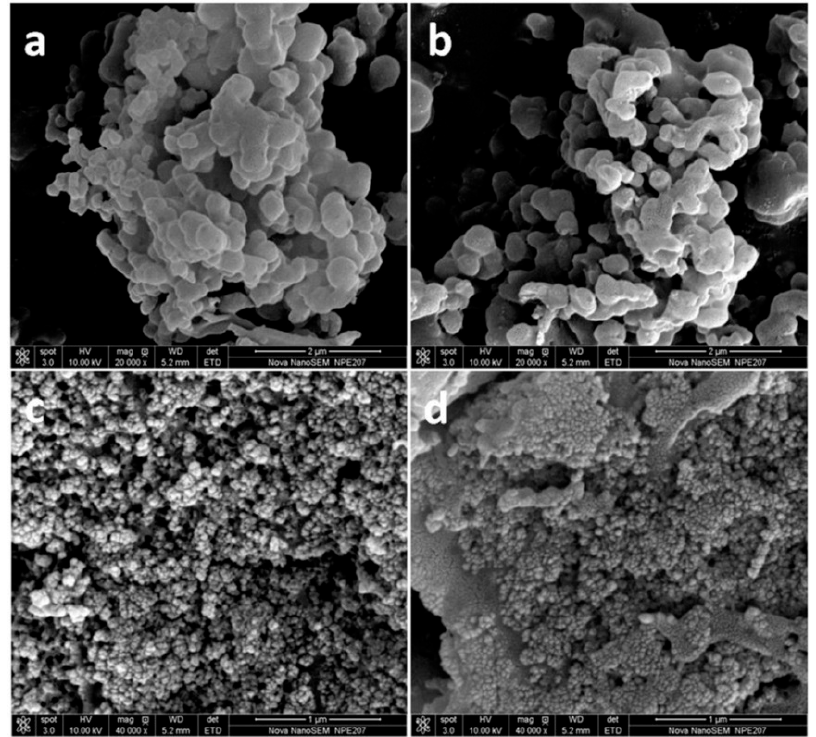
Figure 4. SEM images of Fe 3 O 4 -CTs@MIP ( a ), Fe 3 O 4 -CTs@NIP ( b ), Fe 3 O 4 -MAH- β -CD@MIP ( c ) and Fe 3 O 4 -MAH- β -CD@NIP ( d ).